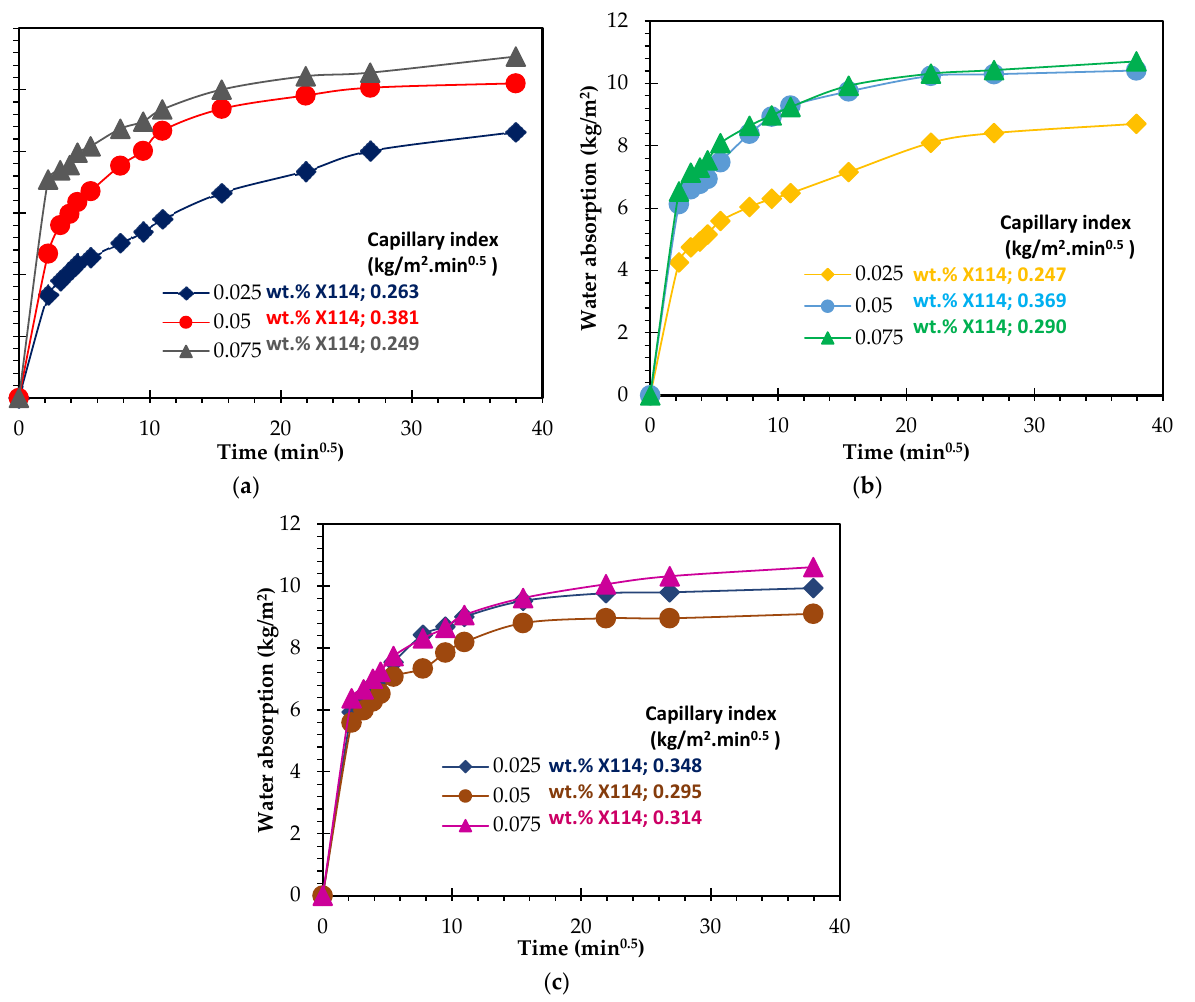
Figure 9. Capillary water absorption and index of GFs prepared with different content (0.025, 0.05, and 0.075 wt.%) of Triton X114 and ( a ) 0.05 wt.% Al, ( b ) 0.075 wt.% Al, and ( c ) 0.1 wt.% Al.